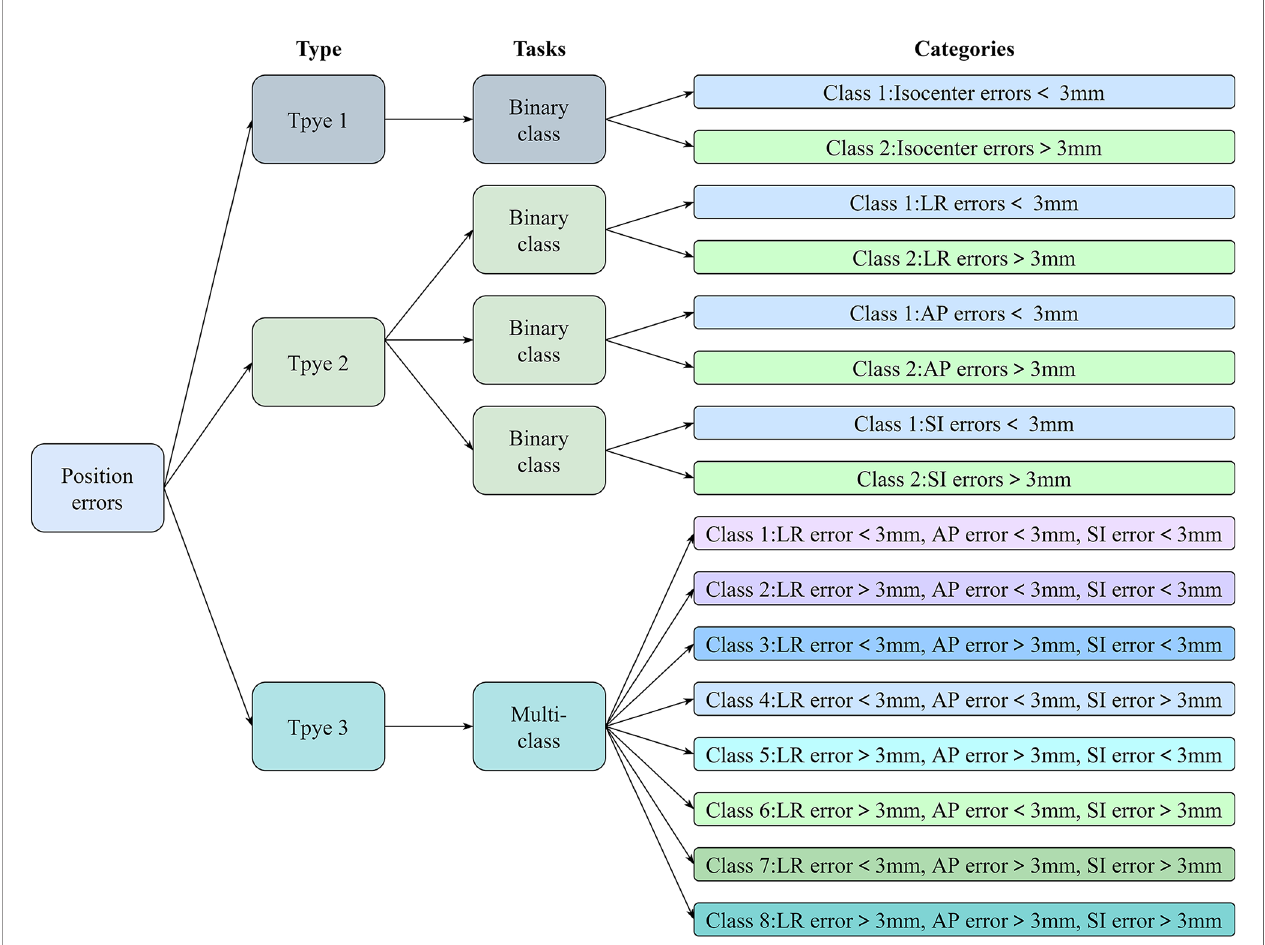
FIGURE 3 | Overview of position error classi fi cation types and classes per type. LR, left-right; AP, anterior-posterior; SI,